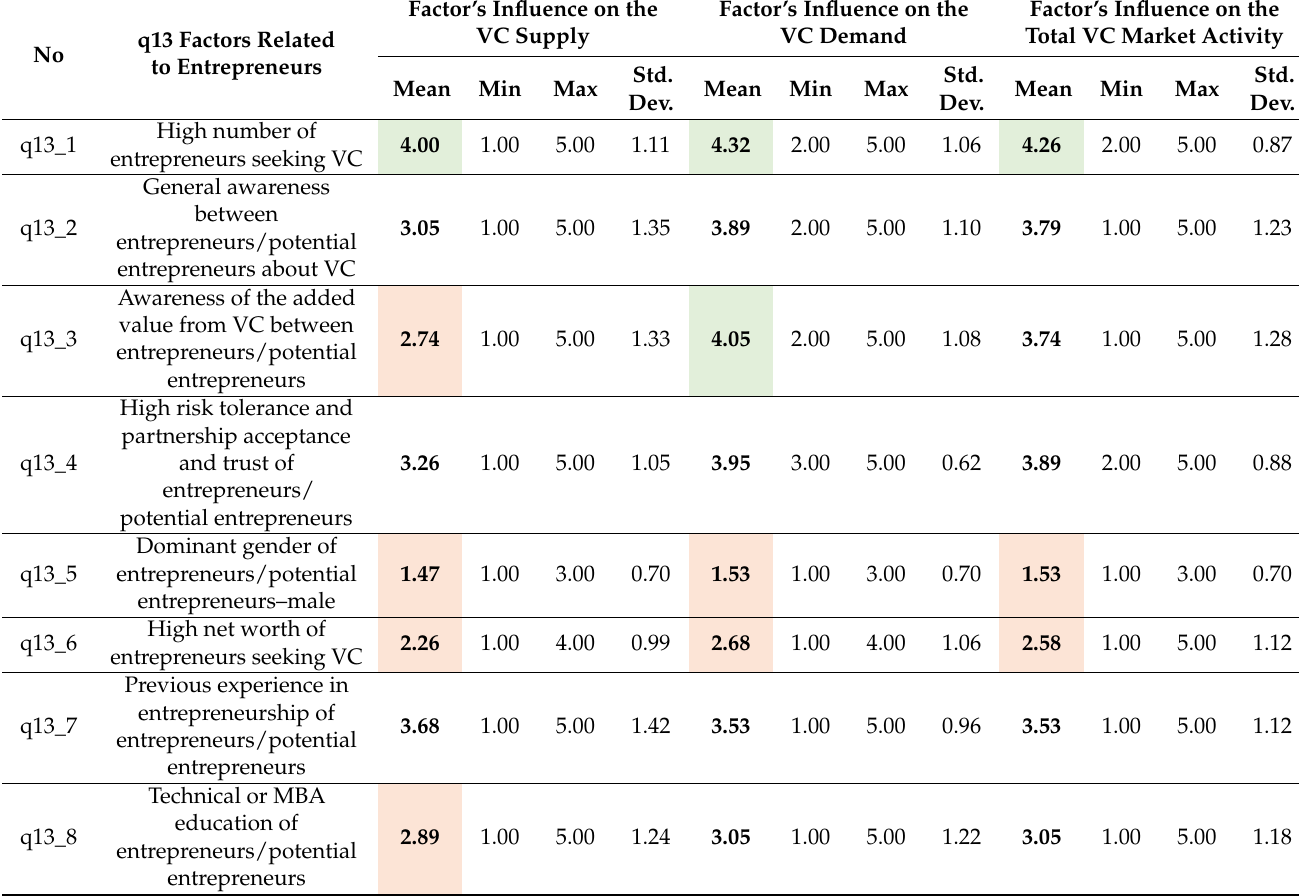
Table 10. The subfactors related to the